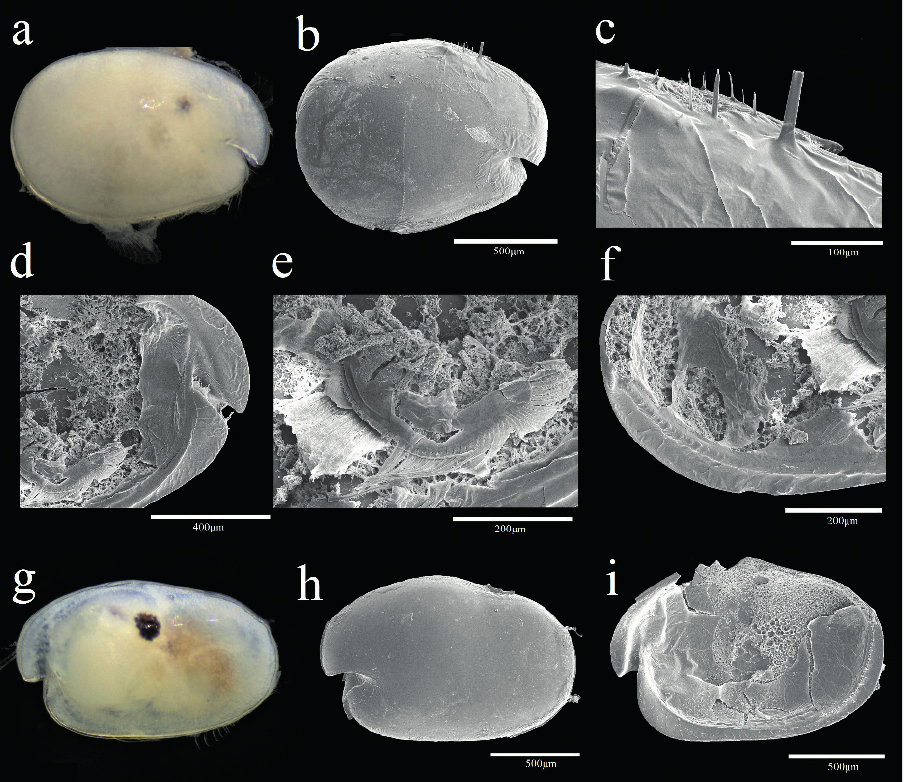
Figure 2. Light microscopy and scanning electron microscopy images of Parasterope busanensis sp. nov. a–f holotype female adult: a External view b Lateral view from left valve c Spines on dorsal margin d In- ternal view of anterior part e L5 ventral section f Internal view of posterior part g, h paratype male adult: g External view h Lateral view from right valve i Internal view of left